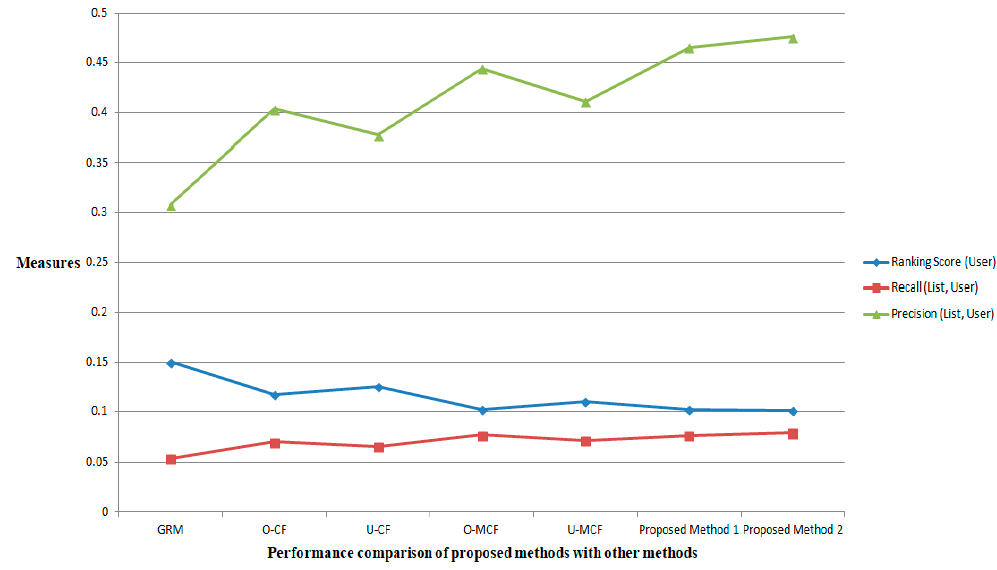
Figure 5. The Performance Comparison of the Proposed Methods with Other Methods [49]: MovieLens